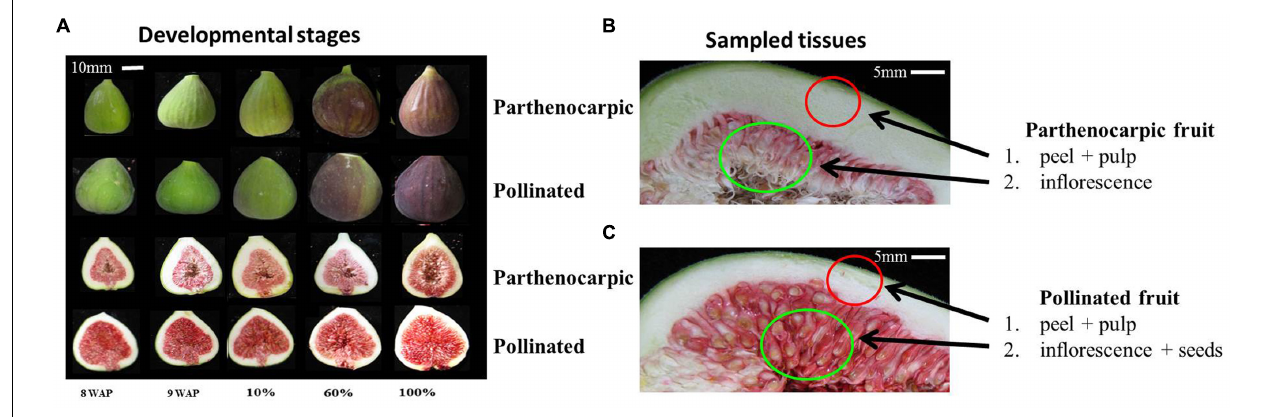
FIGURE 1 | Fig fruit developmental stages and tissues used to extract RNA and construct cDNA libraries for the Illumina high-throughput sequencing. (A) Developmental stages of parthenocarpic (top rows of each set) and pollinated (lower rows of each set) fruit displaying pulp and inflorescence; 8WAP – 8 weeks after pollination; 9WAP – 9 weeks after pollination; 10% – 10% fruit ripening; 60% – 60% fruit ripening; 100% – 100% fruit ripening. (B) Parthenocarpic sampled tissues that were used in this study. ( C ) Pollinated sampled tissues that were used in this